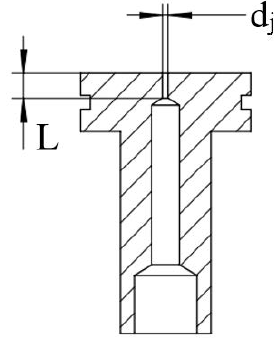
Figure 2. Schematic of the test section.